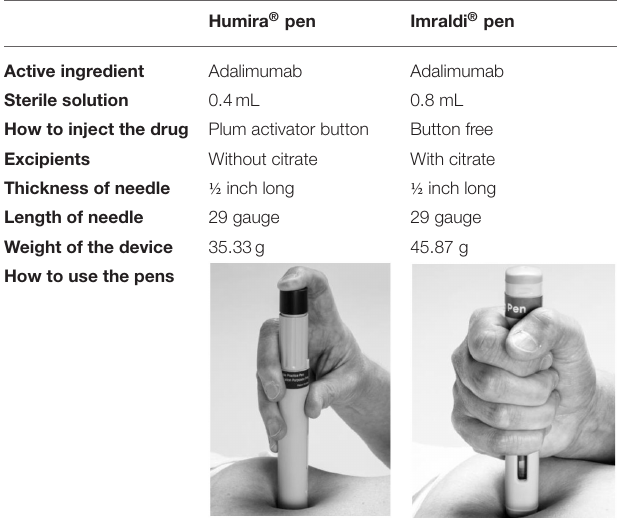
TABLE 1 | The table illustrate differences between two devices that contain adalimumab: Humira ® pen and Imraldi ® pen. Humira ®